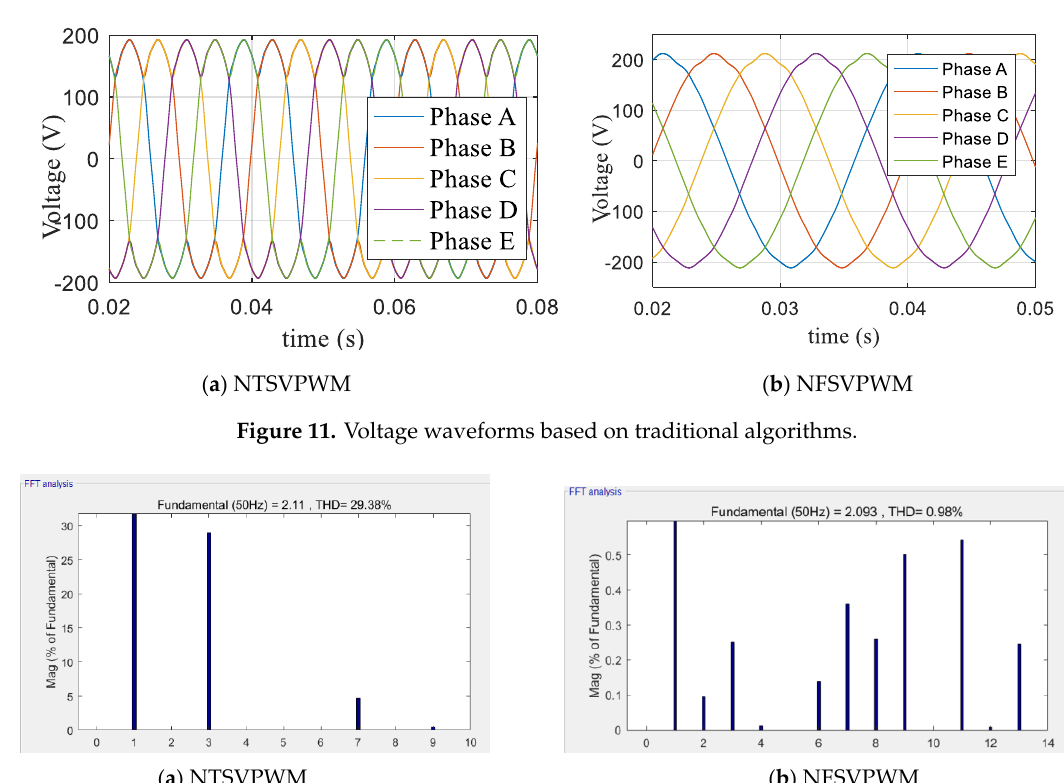
Figure 12. Harmonic characteristics at m = 1.0514.